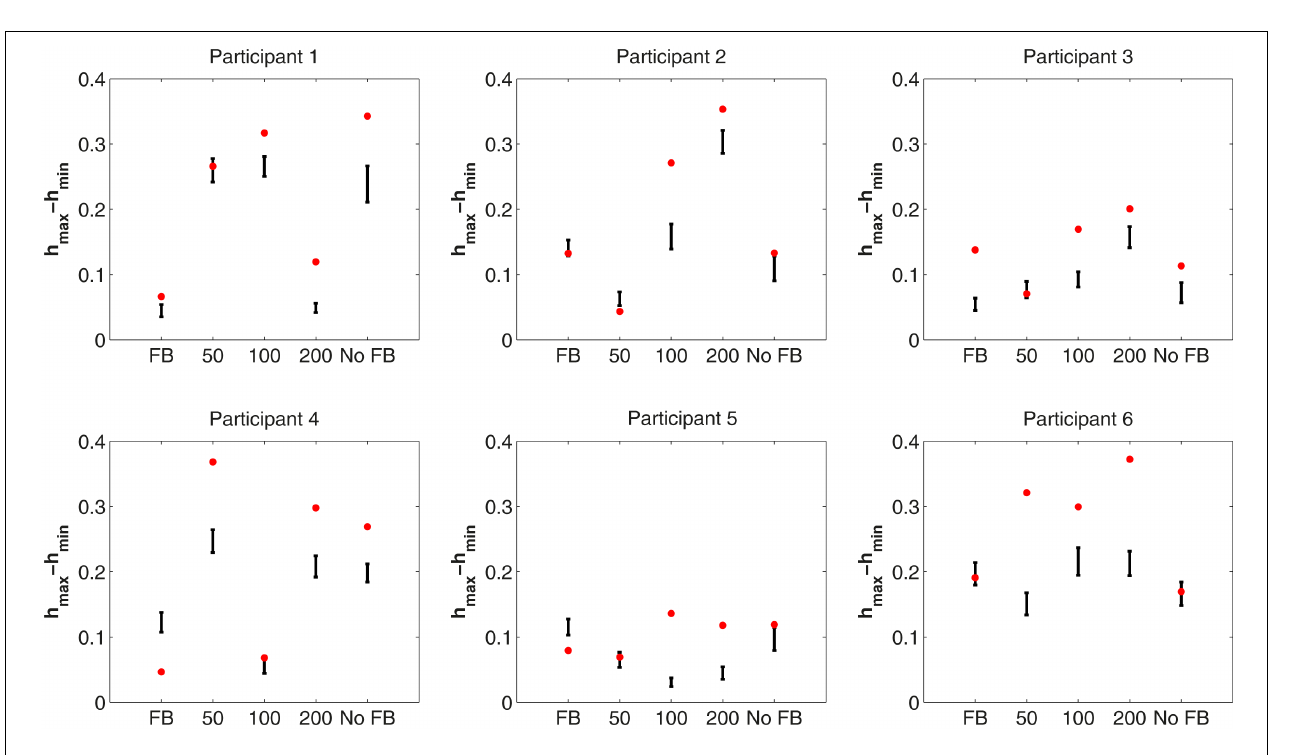
FIGURE 5 | Results from the multifractal analysis of ITI response series for each participant and each condition. The width of the multifractal spectrum width ( h max − h min ) is shown by a red dot. Ninety-five percentage